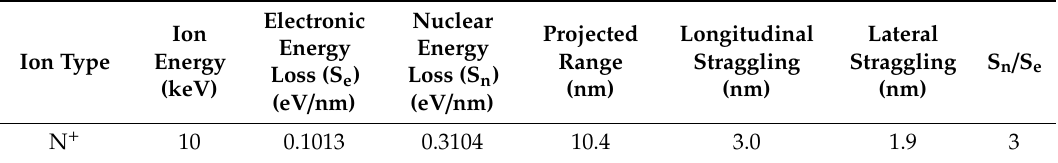
Table 1. Electronic and nuclear energy loss, longitudinal straggling and lateral straggling calculated from stopping and range of ions in matter (SRIM)